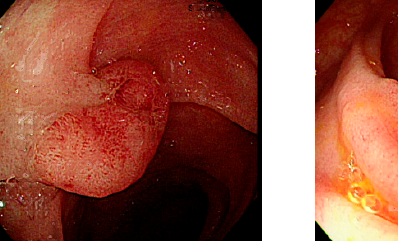
Figure 14. Excessive noise images.